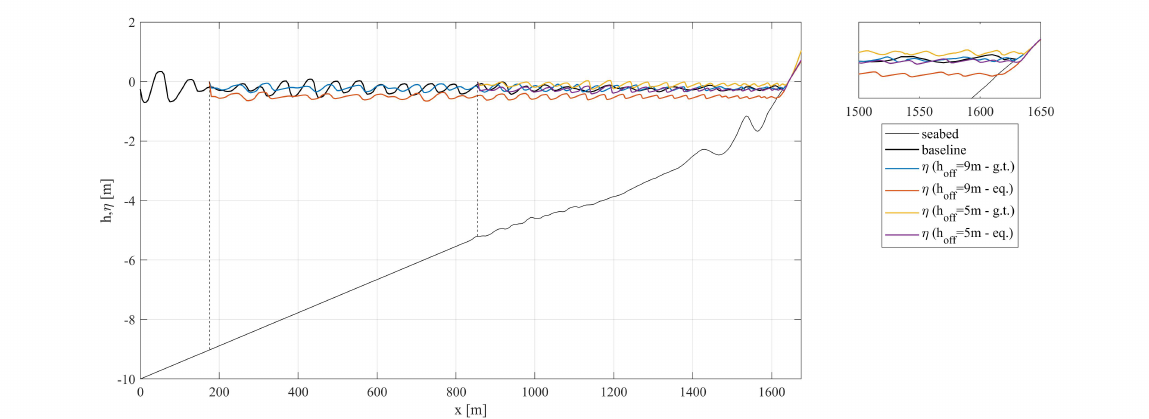
Figure 9. Cross-section of free-surface level at t = 1000 s ( ∼ 135 waves) for the ESE tests: baseline simulation (black thick line) vs. flood simulations (colored lines). The starting points of the flood simulations, corrsponding to h ≈ 9 m and h ≈ 5 m, are also illustrated (vertical dashed lines). The little right panel shows a close-up view in the shallowest